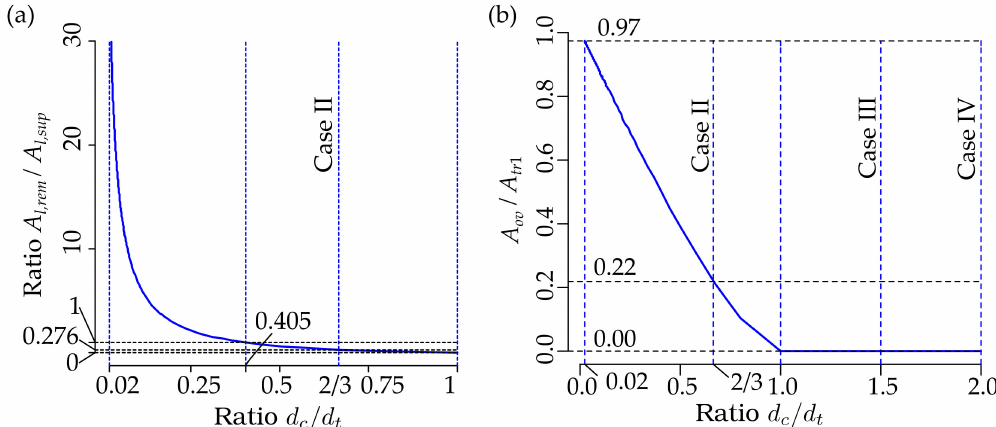
Figure 13. The dependencies of the ratios A l , rem / A l , sup and A ov / A tr ,1 on the ratio d c / d t of the considered plate, see Figure 1: ( a ) A l , rem / A l , sup versus d c / d t ∈ [ 0.02, 1 ] ; and ( b ) A ov / A tr ,1 versus d c / d t ∈ [ 0.02, 2 ]